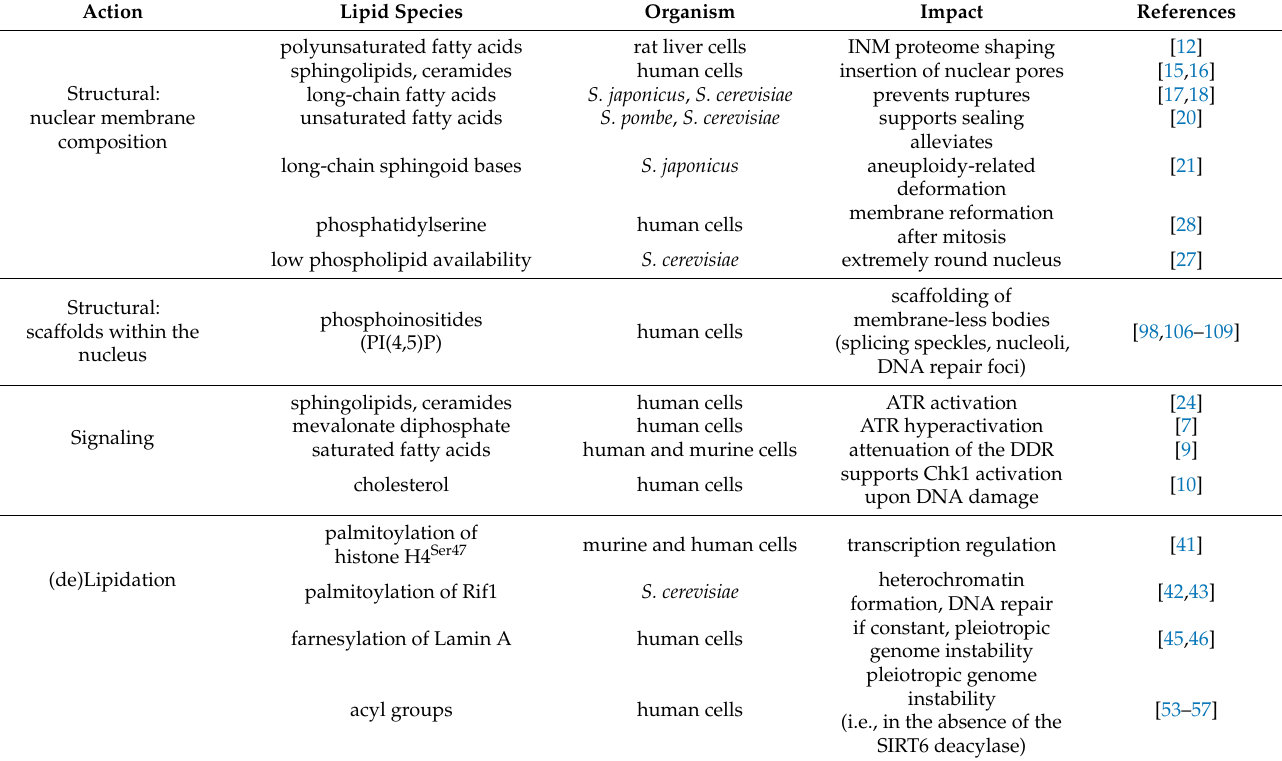
Table 1. Compendium of demonstrated roles of lipid species on nuclear